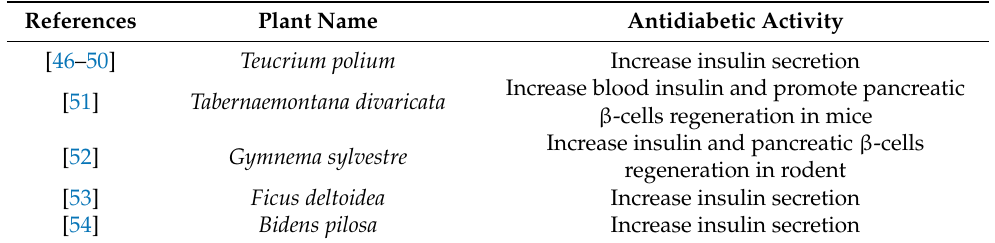
Table 1. Some antidiabetic medicinal plants with potential insulin secretagogue